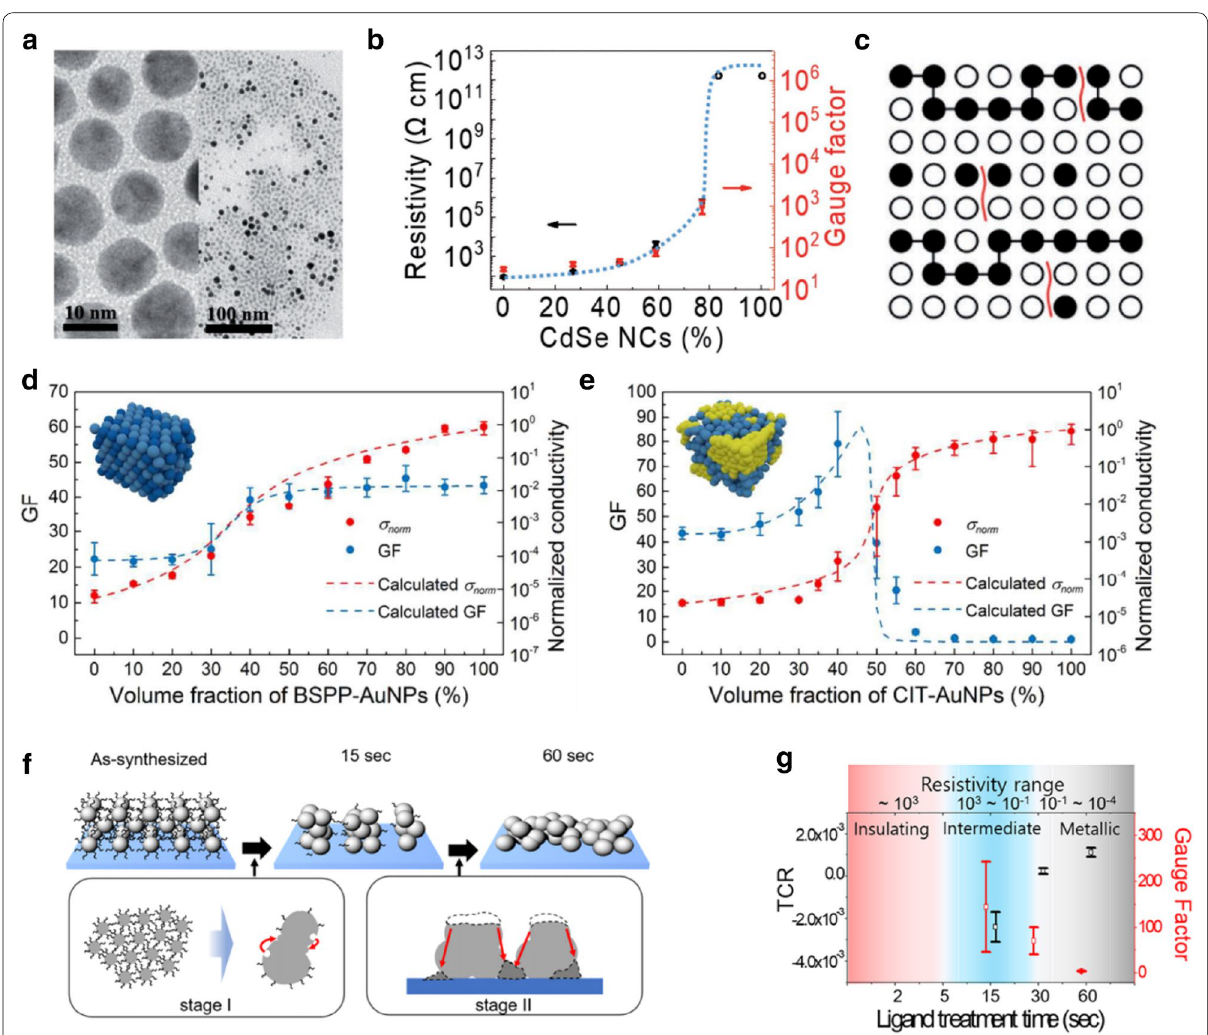
Fig. 3 a TEM images of (left) pure Au NC and (right) Au-CdSe hybrid NC thin films. b Resistivity and gauge factor of Au-CdSe NC hybrid thin films with cracks depending on the fraction of CdSe NCs. c Schematic of square lattice structures for Au-CdSe NC hybrid thin films with cracks according to the site and bond percolation model. The conductivities and gauge factor of d homogeneous arrangement shell binary NC materials (SBNM)